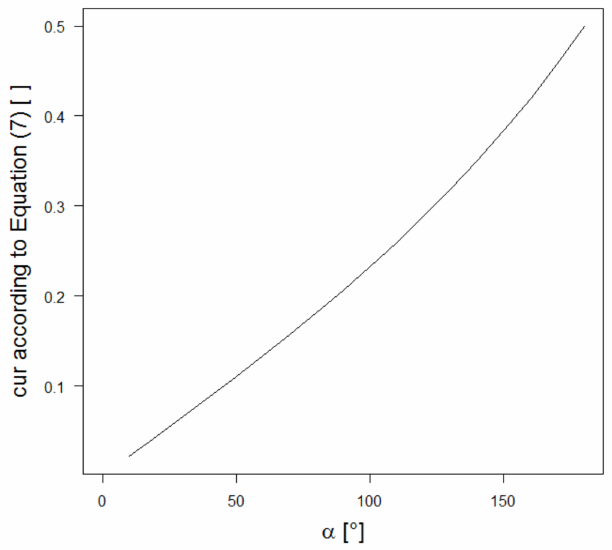
Figure 10. Influence of alpha (and consequently the log length) on the curvature value on a fictive and theoretical log model with a constant radius. The higher alpha (and thus the longer the log), the higher the curvature value for a constant radius (and consequently a constant